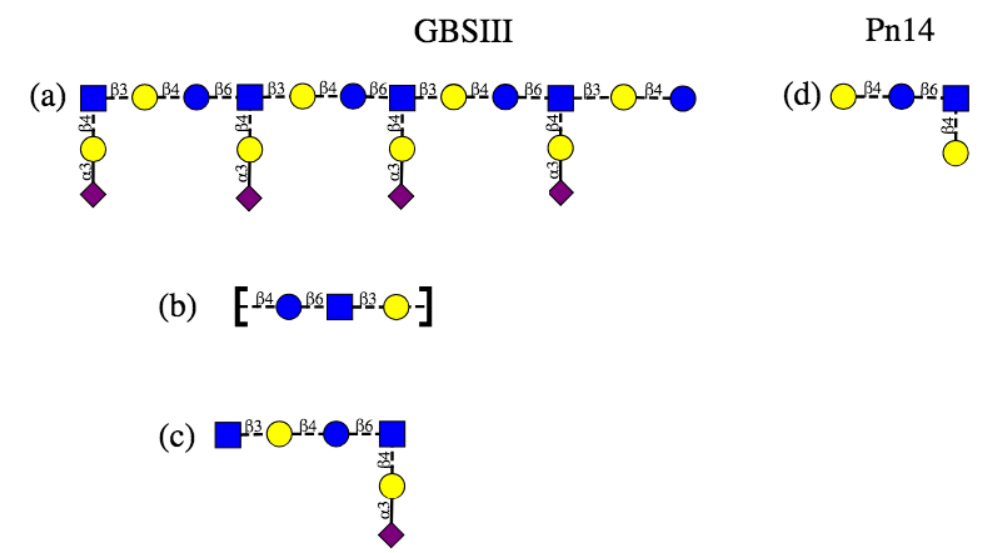
Figure 1. Schematic representation of the protective epitopes previously identified for GBS PS (left column) and Pn14 PS (right column). GBSIII: ( a ) 3–4 RU helical conformational epitope postulated for GBSIII PS [10,11]; ( b ) the linear backbone epitope identified from fragment binding to GBSIII antibodies [14] and ( c ) a 6-residue epitope identified from a DP2-Fab crystal structure [13]. Pn14: ( d ) the tetrasaccharide epitope first identifed by Safari et al. [7,14] and then by Kurbatova et al. [15] from antibody studies. Structures are depicted using the ESN symbol set [16] with yellow circle: Gal, blue circle: Glc, blue square: GlcNAc, purple diamond: